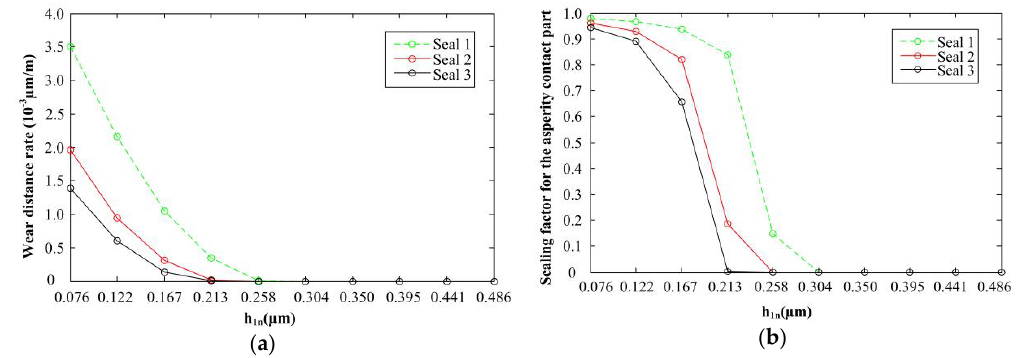
Figure 12. ( a ) Wear distance rate of the non-Gaussian surfaces for different thicknesses of the tapered film; ( b ) scaling factor for the asperity contact of the non-Gaussian surfaces for different thicknesses of the tapered film.